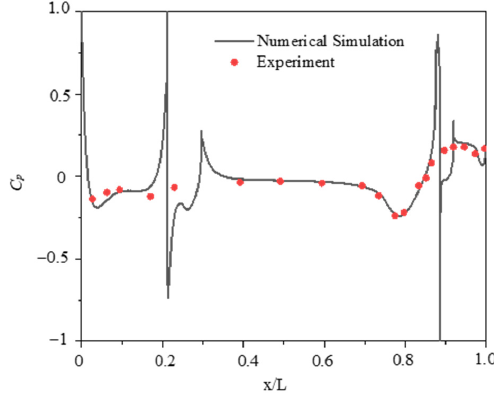
Figure 4. C p along the upper meridian line.